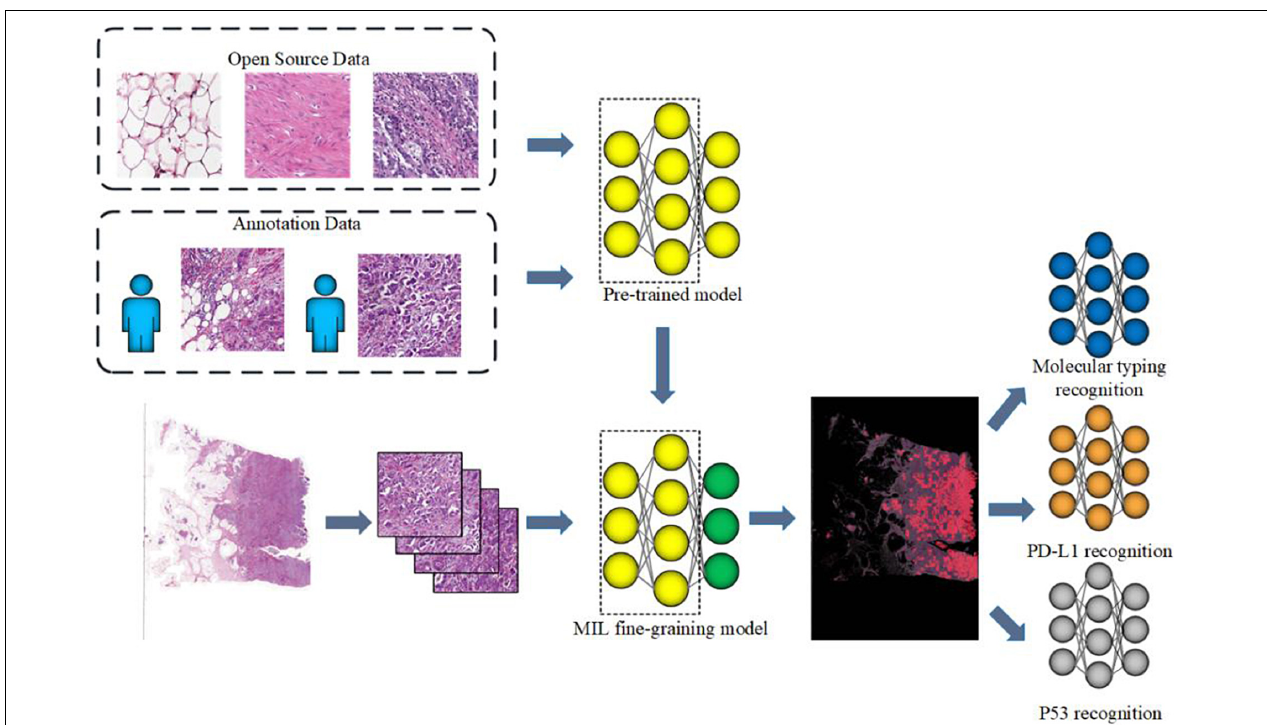
FIGURE 1 | Workflow of muscle-invasive bladder cancer (MIBC) histopathological molecular information recognition with convolutional neural networks (CNNs).